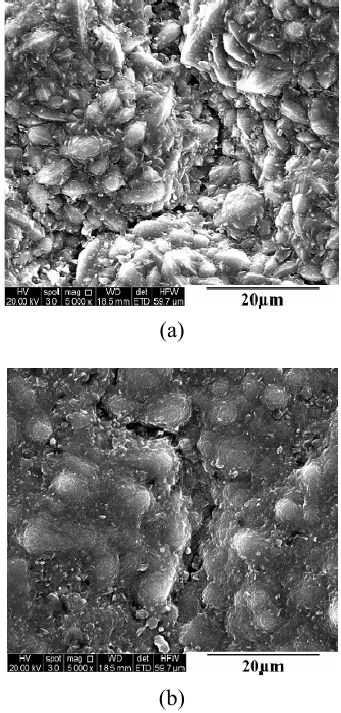
Fig. 11 SEM images of the SiC coating surface: (a) before the HT test, (b) after the HT test.